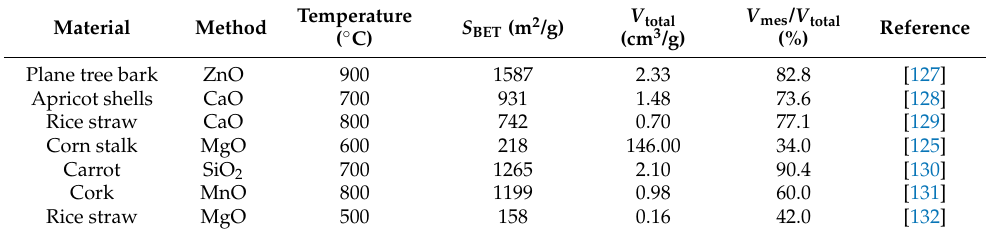
Table 5. Preparation of plant-derived carbon materials by hard template